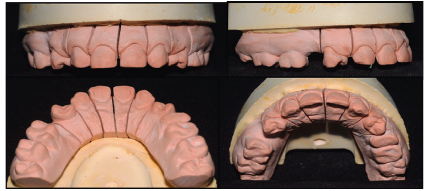
Figure 12: Laboratory steps for manufacturing of ceramic laminates. (a) Fixation of the waxed veneers at the base, (b) adaptation of the silicone ring at the base, and (c) addition of the coating